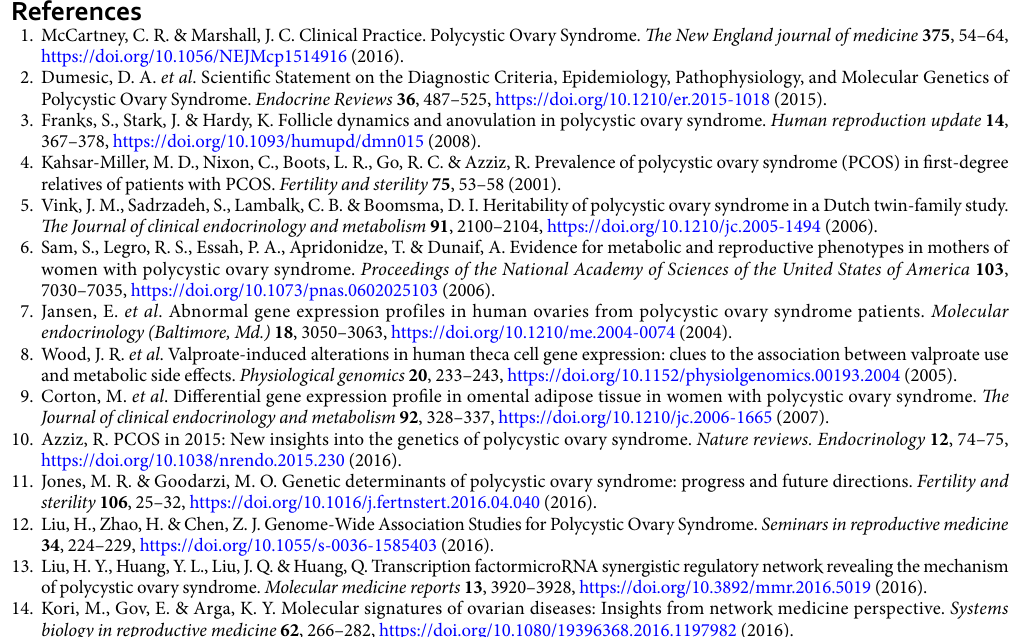
Classifier evaluation.